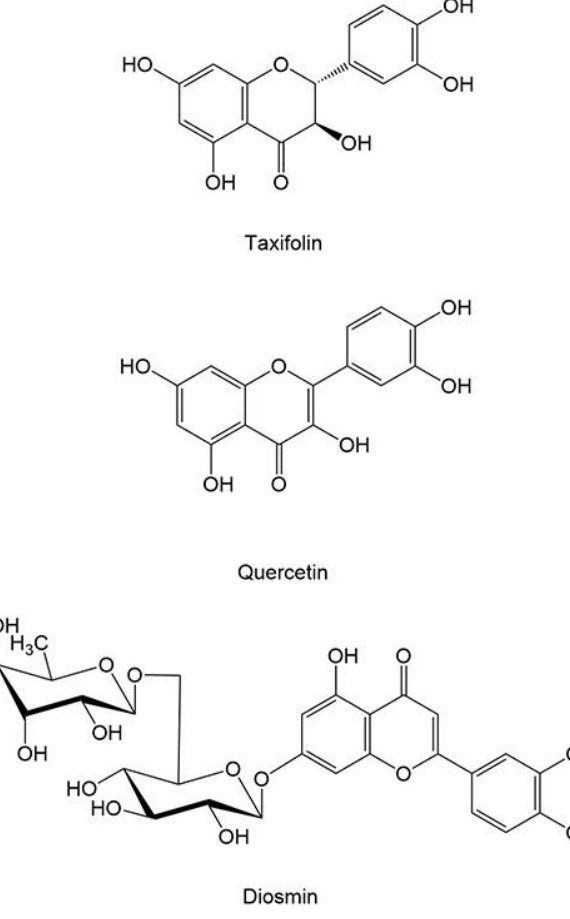
Figure 1. The molecular structure of taxifolin, quercetin, and diosmin.